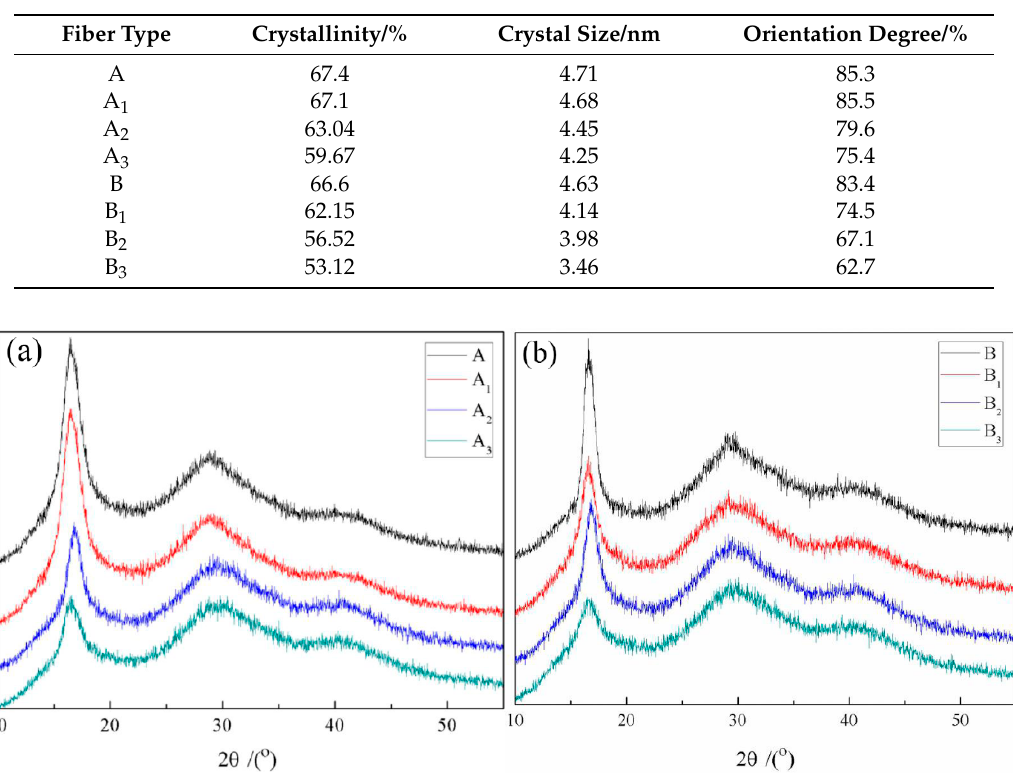
Figure 5. XRD curves of different diameter PAN fibers after modification. ( a ) XRD curves of large diameter; ( b ) XRD curves of small diameter.